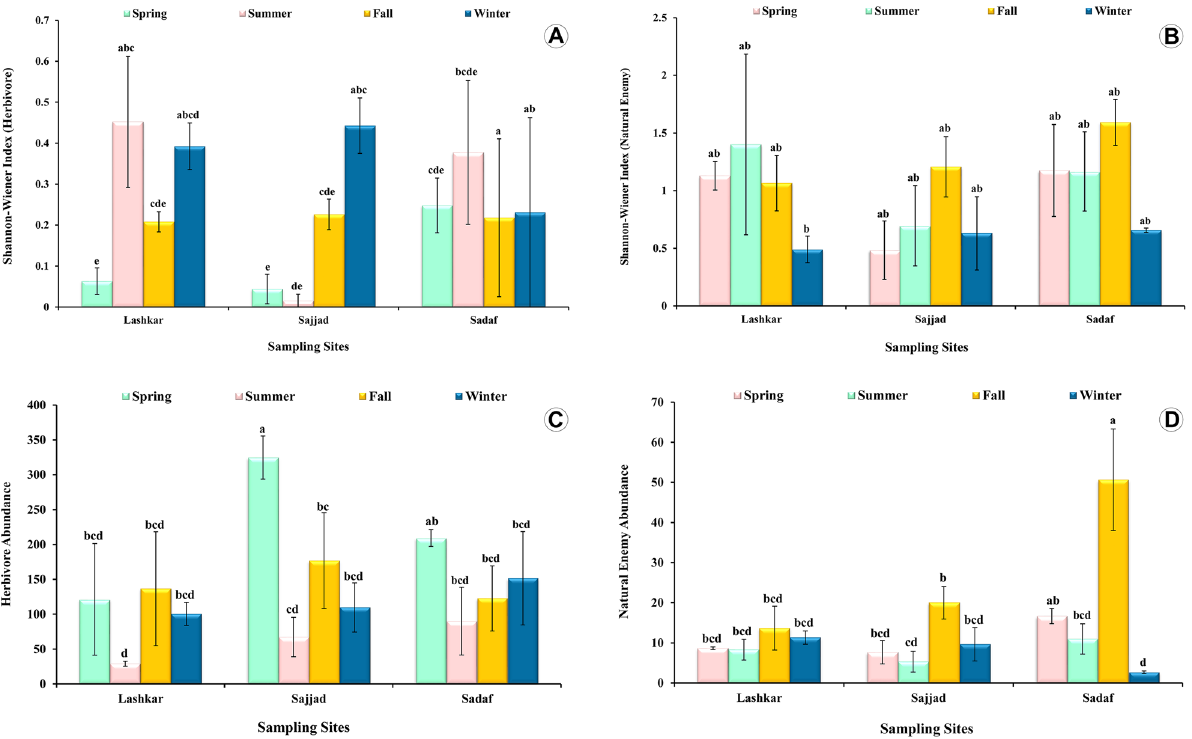
Figure 3. The mean Shannon–Wiener index for diversity and the mean abundance of ( A, C ) Herbivores and ( B, D ) natural enemy associated to Chinese thuja trees, Platycladus orientalis (L.) in three urban green spaces of Mashhad city from Iran during the four seasons. Values of zero are removed from the analysis, ± standard error, n = 3, similar lowercase letters (e.g., ab, bc, bcd, abcd, bcde, etc.) indicate there is no statistically significant difference among different seasons of each sampling